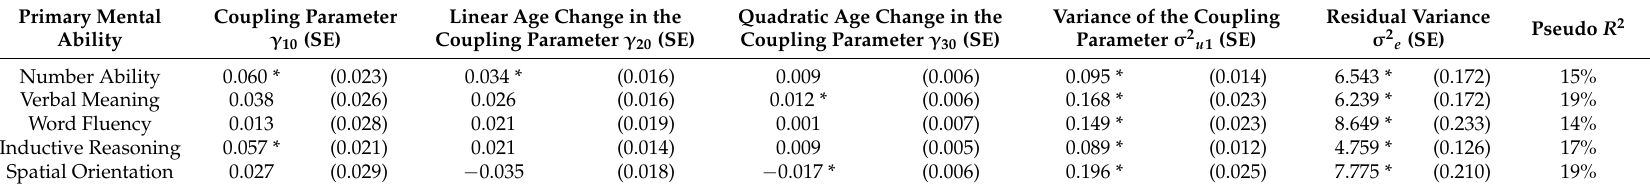
Table 3. Multilevel model examining age-related change in the within-person coupling of primary mental abilities and cognitive